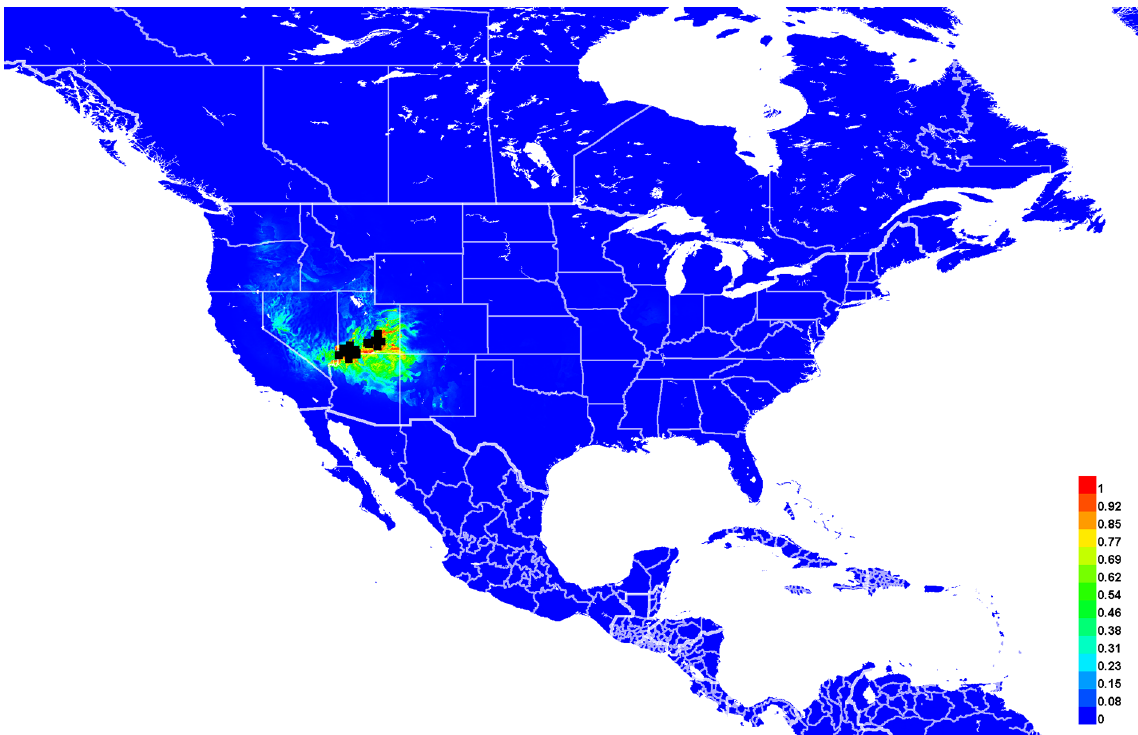
Fig. 24. Georeferenced collection records of Lasioglossum ( D. ) clastipedion sp. nov. (black squares) and predicted distribution by maximum entropy ecological niche modeling in Maxent (colour shading). Warmer colours indicate higher cloglog probability of